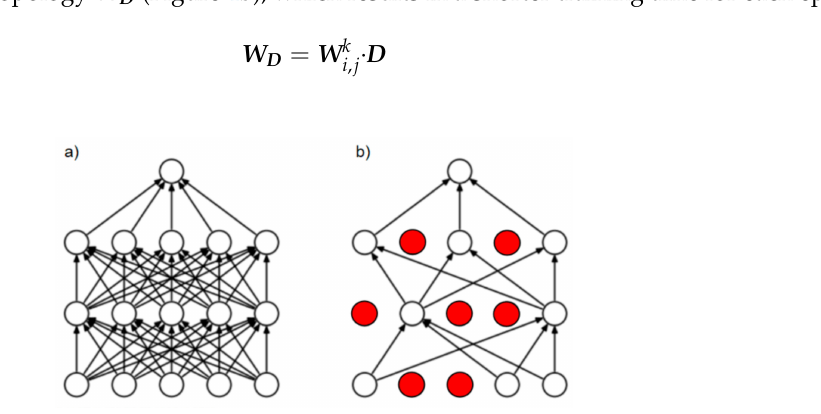
Figure 4. Visualization of dropout operation: ( a ) full network; ( b ) network after dropout.